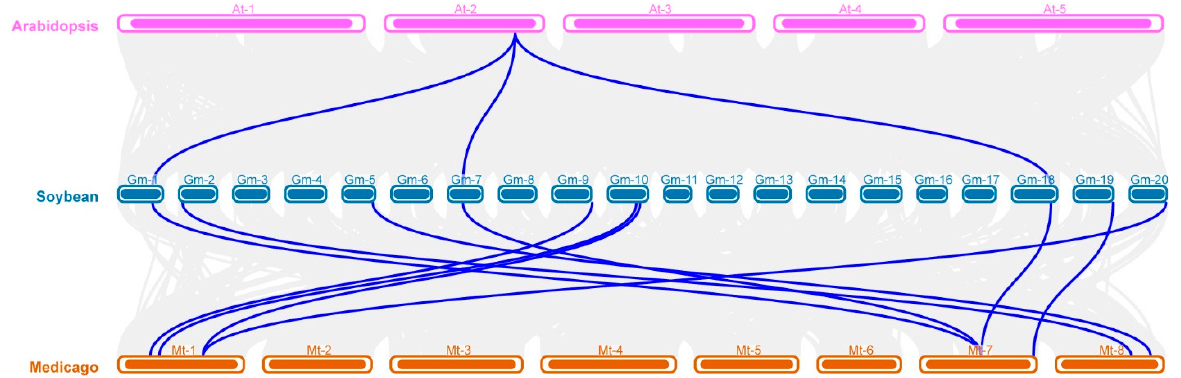
Figure 3. Synteny analysis of AMT genes among Arabidopsis , soybean and Medicago. One Step MCScanX on TBtools was used to analyse gene duplication. Grey lines in the background indicate the collinear blocks within the genomes of soybean, Arabidopsis and Medicago. The blue lines indicate the syntenic AMT gene pairs.